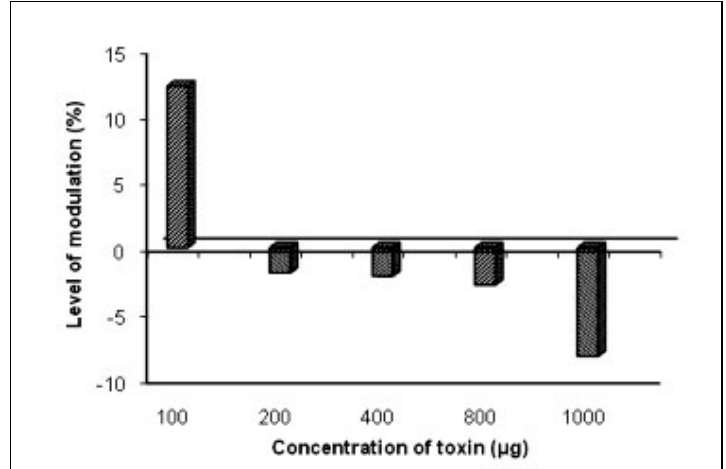
Figure 8. Immunomodulation produced by the chloroform-methanol (2:1) extract of Halichondria panicea